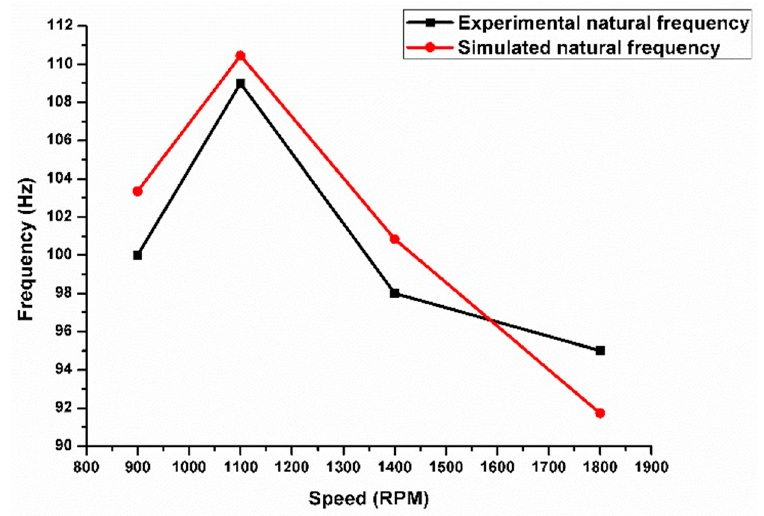
Figure 14. Measured natural frequency values against predicted frequency using modal analysis simulation.